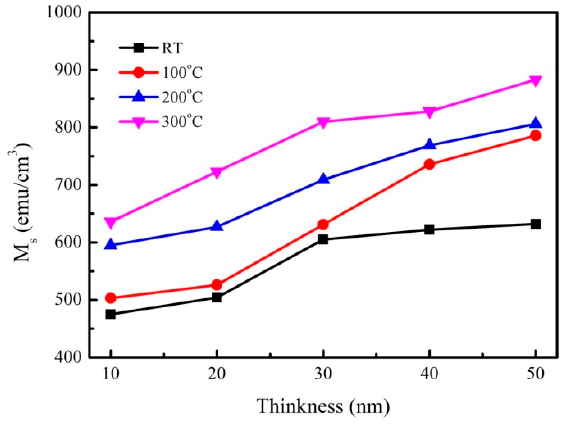
Figure 3. Saturation magnetization (M S ) of CoFeY thin films.